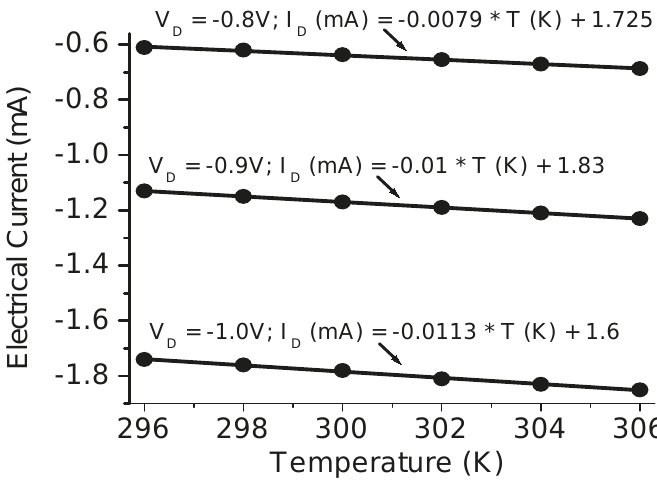
Figure 5. The variation of electrical currents as a function of temperatures at three applied voltages (V R = − 0.8 V, − 0.9 V, and − 1.0 V) for a fabricated silicon diode temperature sensor, where the dots are the experimental data, and the linear current-temperature functions were derived from the regression analysis of the experimental